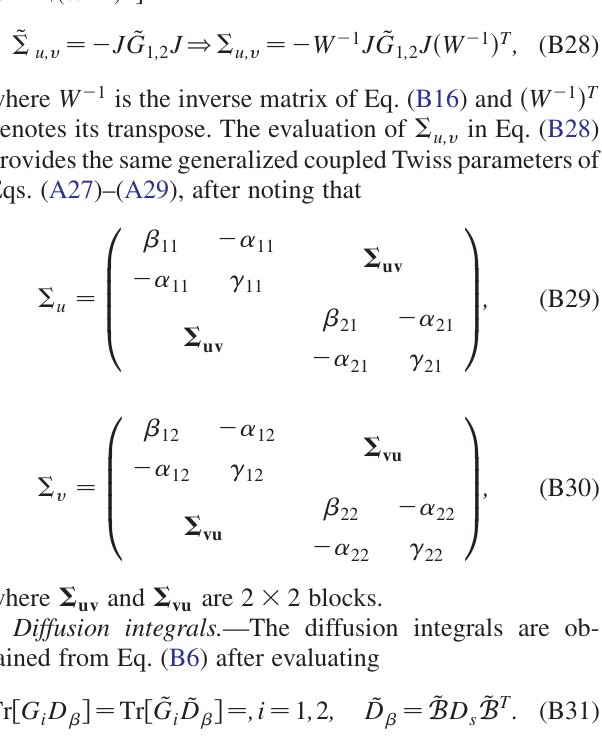
oscillate with q and are assumed to where the terms R (cid:4) 3 ; 4 have a negligible contribute to the diffusion